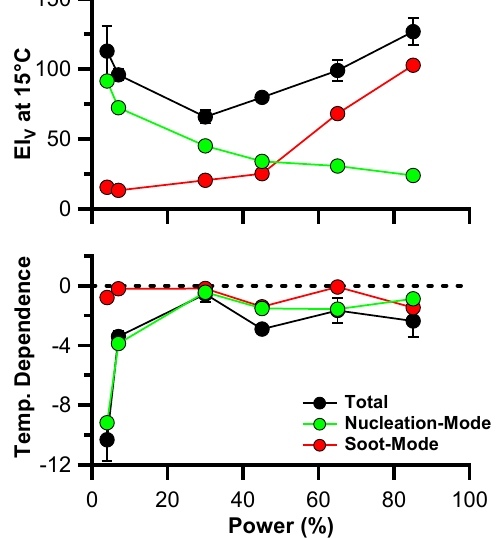
Fig. 10. Total aerosol volume emission index at 15 ◦ C (mm 3 kg − 1 ) and its temperature dependence (mm 3 kg − 1 ◦ C − 1 ) as a function of power as measured at the 30m probe. Error bars are the one-sigma standard deviation of the linear fits for the total aerosol volume fits and may be below the figure resolution. Error bars are not included for the nucleation- and soot-mode volumes for clarity, but uncer- tainties are on the same scale as the total volume uncertainties. Data are solely from the #2